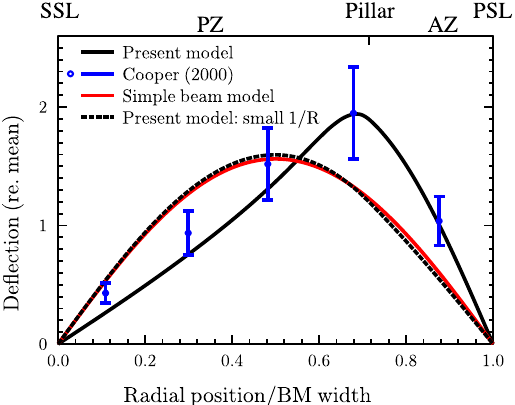
Figure 4. Comparison of predicted BM deflection profiles under pressure load for the ABM (using the model in Fig. 1d) as a function of normalized radial position, at the basal turn, for the present model (solid black line) and measurements from Cooper 27 (blue circles and error bars). Also shown is the deflection profile for the SBM (solid red line) and for the ABM with a small 1/R value, corresponding approximately to a flat beam (dashed black line). The deflection is normalized by the mean deflection. The radial position is normalized by the total BM width, i.e., the distance between the PSL and SSL, as in ref.